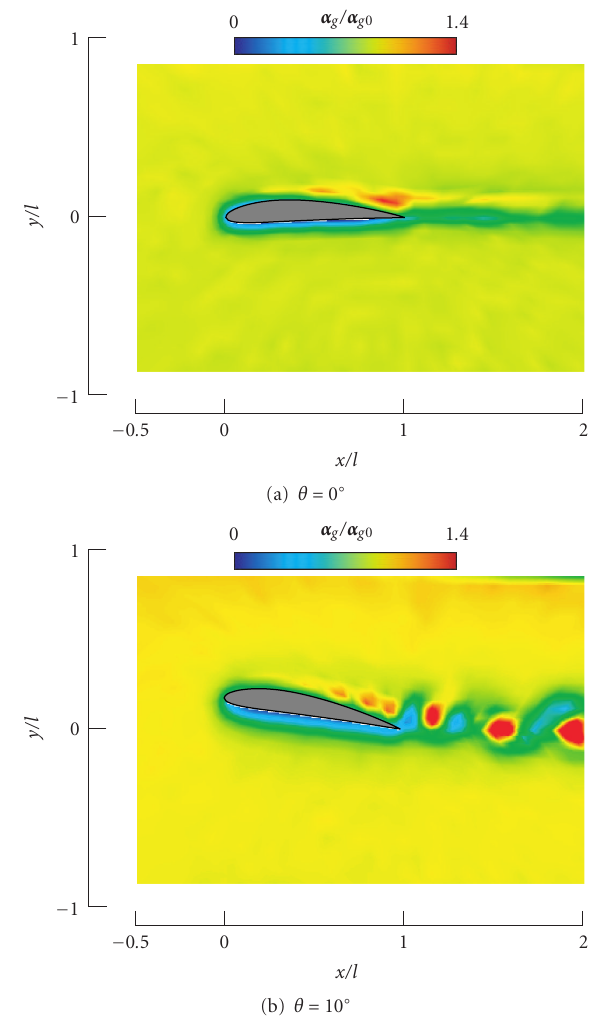
Figure 6: Distribution of air volume fraction.